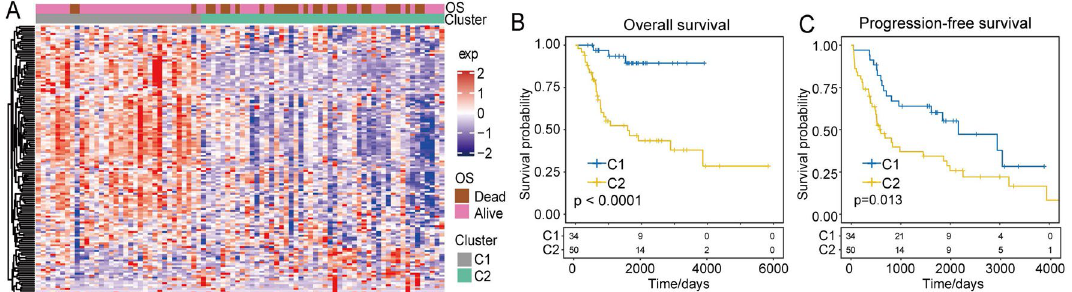
Figure 1. Landscape of immune cell-related gene expression and subtype prognosis. ( A ) Heatmap showing immune cell-related gene expression in the different subtypes. ( B ) Overall survival for the C1 and C2 subtypes. ( C ) Progression-free survival for the C1 and C2